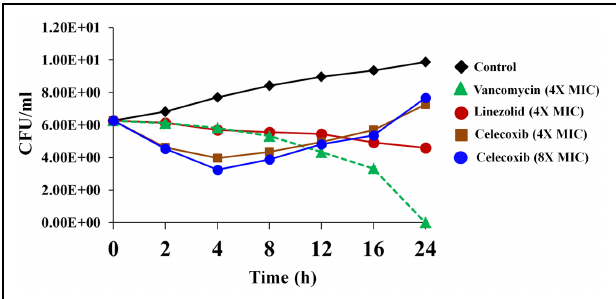
FIGURE 1 | Time-kill assay for celecoxib tested against Staphylococcus aureus . Killing kinetics of celecoxib (4X and 8X MIC), vancomycin (4X MIC), and linezolid (4X MIC), against methicillin-resistant S. aureus (MRSA) USA300 in MHB are shown. The results are presented as means ± SD ( n = 3). Data without error bars indicate that the SD is too small to be